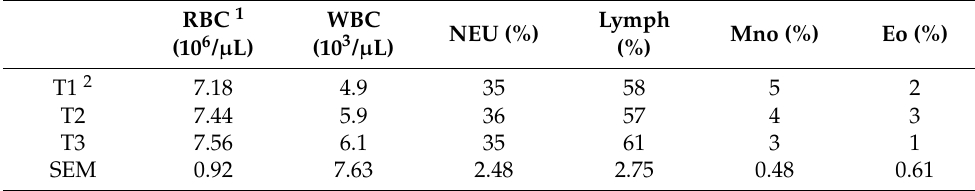
Table 5. Blood parameters changes of mice when supplemented with different diets.